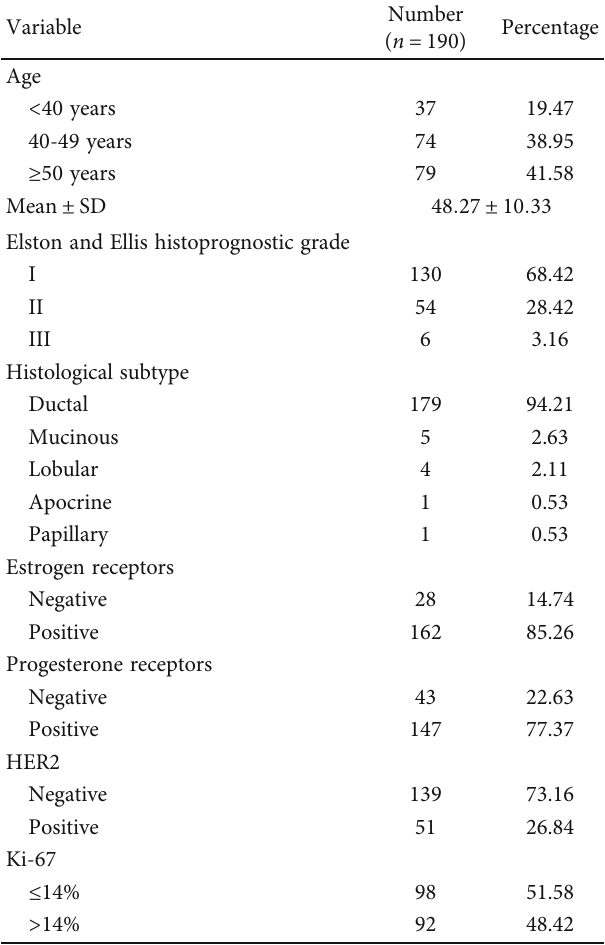
Table 1: Age, pathological, and immunohistochemical characteristics of breast